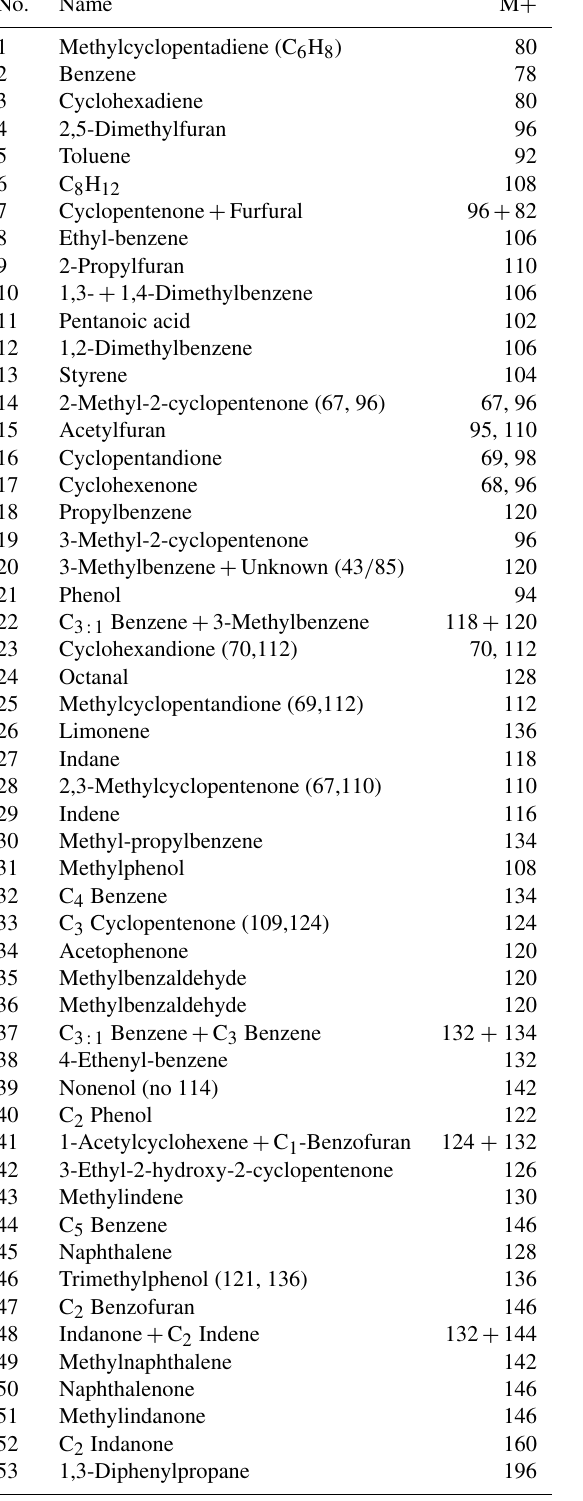
Table 1. Compounds identified in the pyrolysate ∗ .